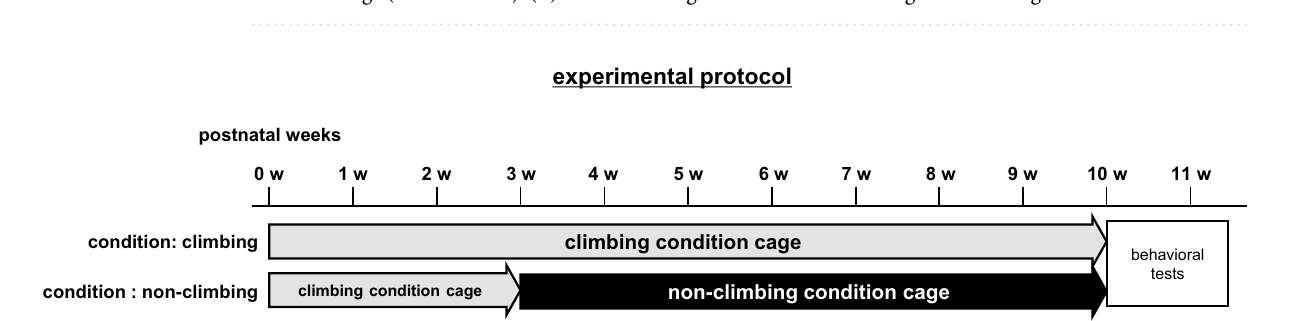
Figure 1. The cages used in the climbing and non-climbing conditions. ( A) Sample picture of a metal grid lid and one covered with Plexiglas. ( B ) Sample picture of a non-climbing condition cage (from above). ( C ) Sample picture of a non-climbing condition cage (from diagonally above). ( D ) Sample picture of a non-climbing condition cage (from the side). ( E ) Schematic diagram of the non-climbing condition cage.